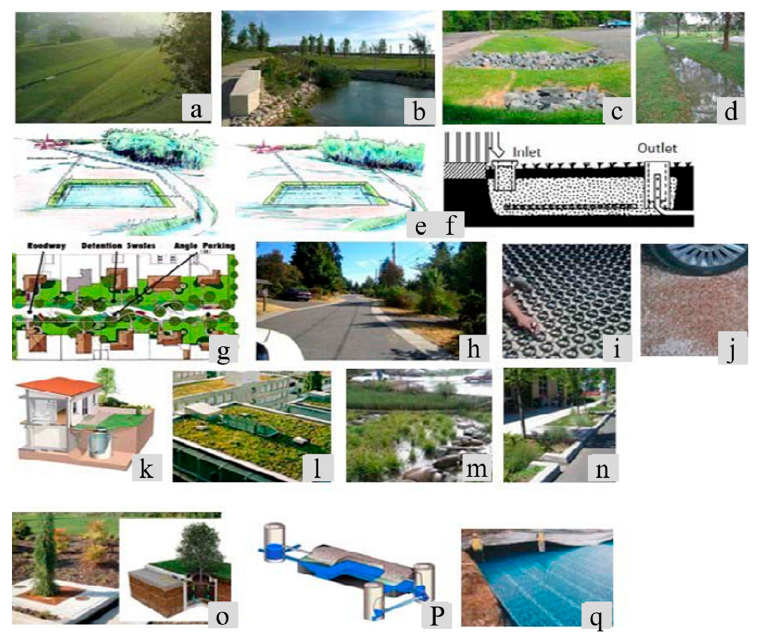
Figure 3. Examples of structural flood mitigation measures: ( a ) retention basin; ( b ) detention pond; ( c ) infiltration pond; ( d ) drainage ditches; ( e ) flow discharge and flow energy control (with parallel and series retention basins); ( f ) infiltration trenches; ( g ) detention swales; ( h ) plants tolerant to flooding and erosion resistance; ( i ) structural shapes for permeable parking; ( j ) permeable paving; ( k ) micro reservoirs; ( l ) green roofs; ( m ) rain gardens; ( n ) pluvial seedbeds; ( o ) individual infiltration; ( p ) storage blocks with drainage ditches; ( q ) modular storage of ground water runoff.